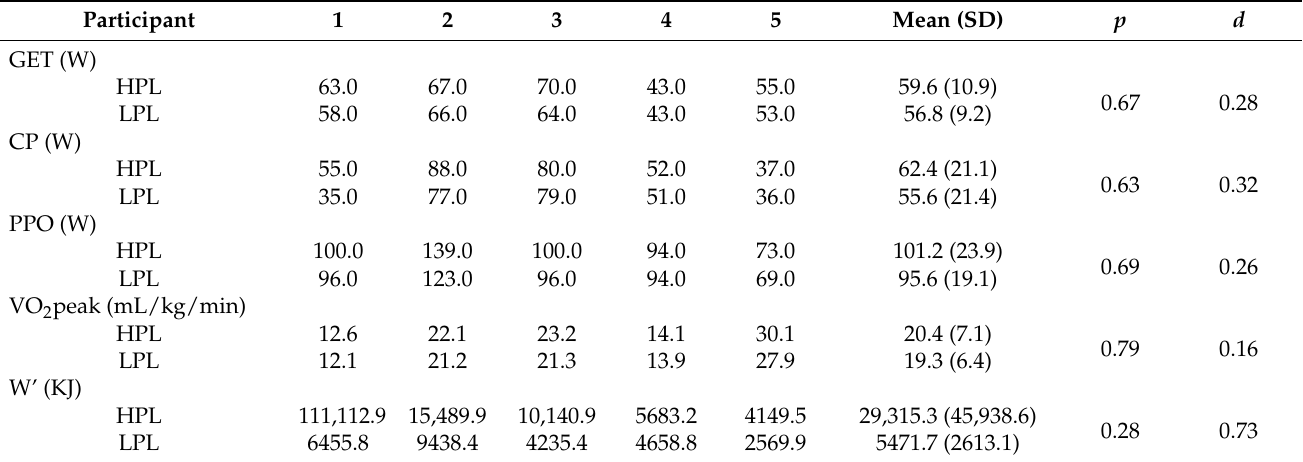
Table 2. Physiological data from single leg incremental cycling test and critical power trials (N =